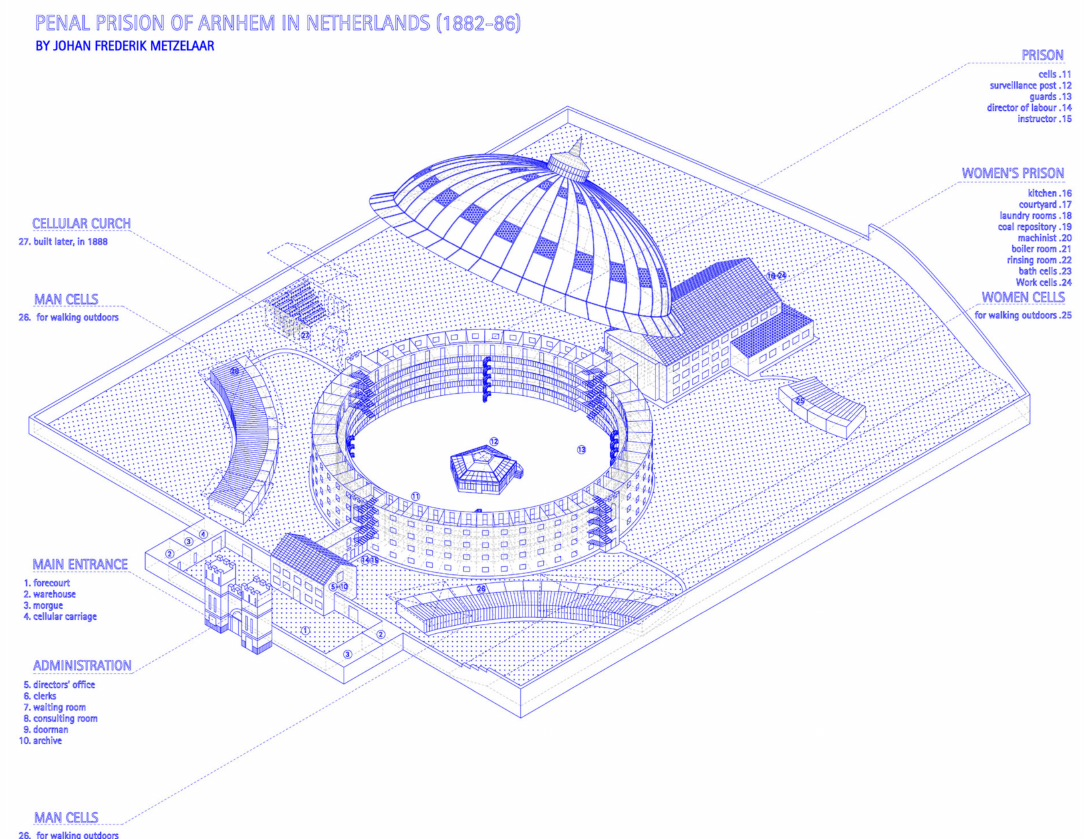
Figure 2. Drawing made for this analysis of the Koepelgevangenis in Arnhem,